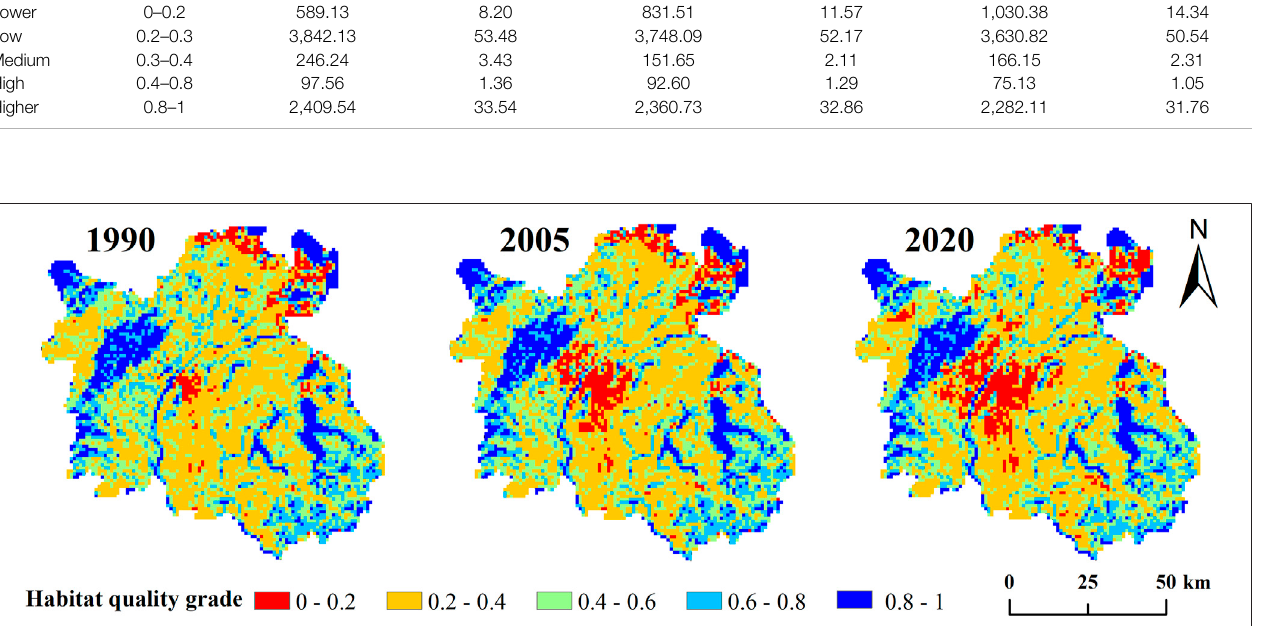
FIGURE 5 | Spatial distribution pattern of habitat quality in 1990, 2005, and